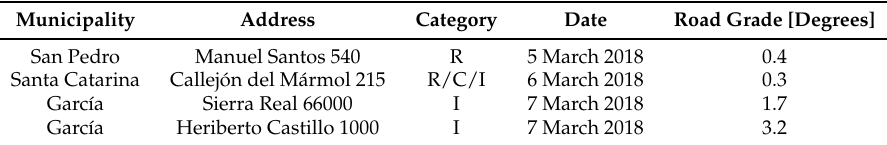
Figure 3. Remote Sensing Device (RSD) technique illustration. Source: Authors’, based on Reference [18]. Table 1. Monitoring campaign carried out in MMA in